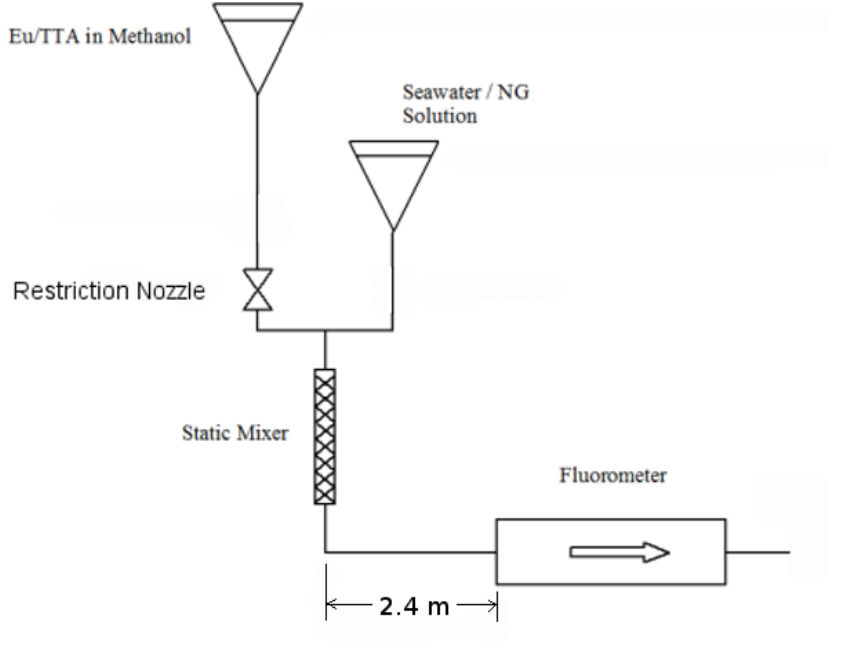
FIGURE 1. Fluorometer flowing setup